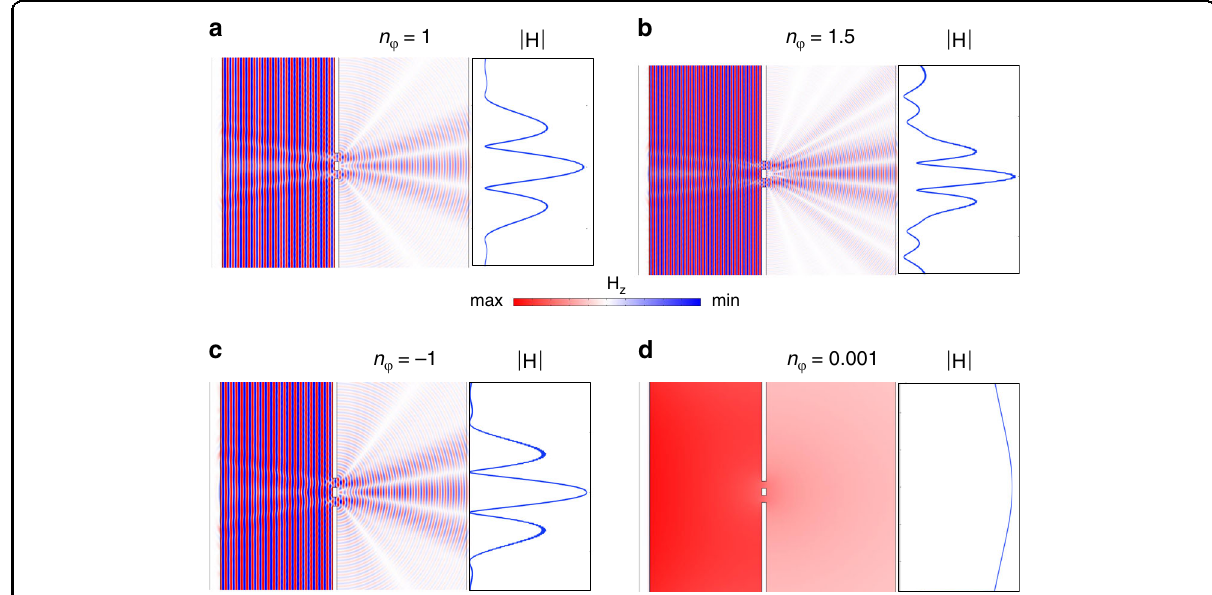
Fig. 4 Young double-slit experiment within different dispersive materials. Left: j H z j fi eld maps, right: j H j pro fi le on the observing screen. a Air ( ε ¼ μ ¼ 1, n φ ¼ 1), b dielectric material such as glass ( ε ¼ 2 : 25 ; μ ¼ 1, n φ ¼ 1 : 5), c a negative refractive index material ( ε ¼ (cid:2) 1 ; μ ¼ (cid:2) 1, n φ ¼ (cid:2) 1) and d an ENZ material ( ε ¼ 1 ´ 10 (cid:2) 6 , μ ¼ 1 and n ¼ 0 : 001). Wavelength is set to 500 nm for a separation width of 800